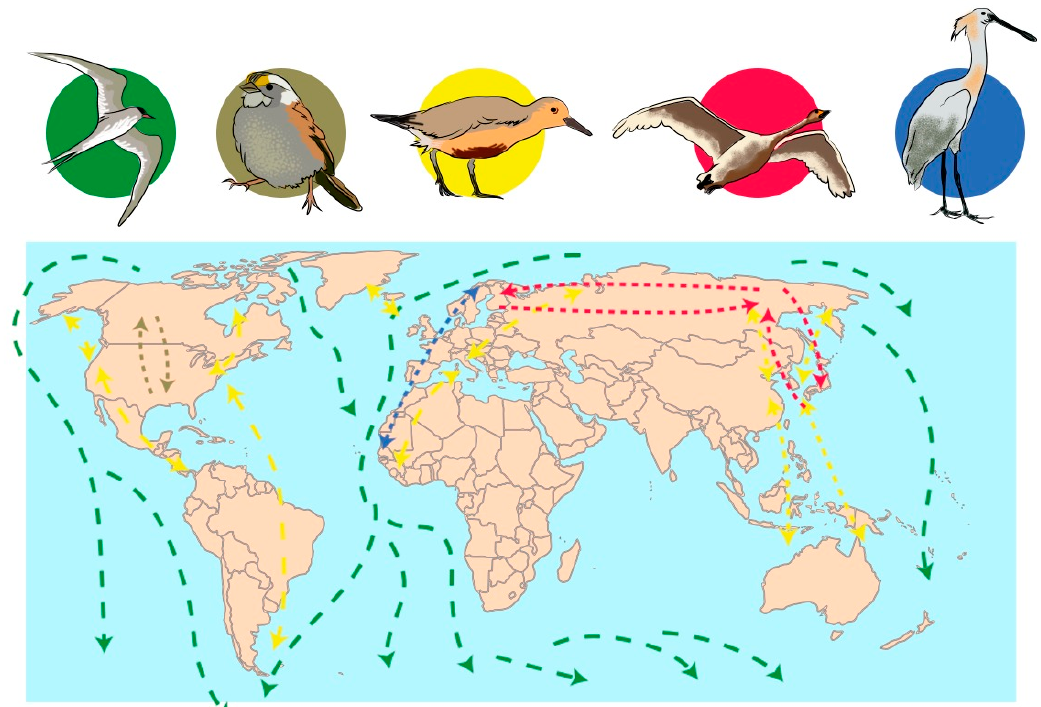
Figure 4. Simplified geographical examples of migratory routes of birds: In green, Sterna paradisaea ; in brown, Zonotrichia albicollis ; in yellow, Calidris canutus ; in red, Cygnus cygnus ; in blue, Platalea leucorodia. This figure was built based on information that is more detailed at